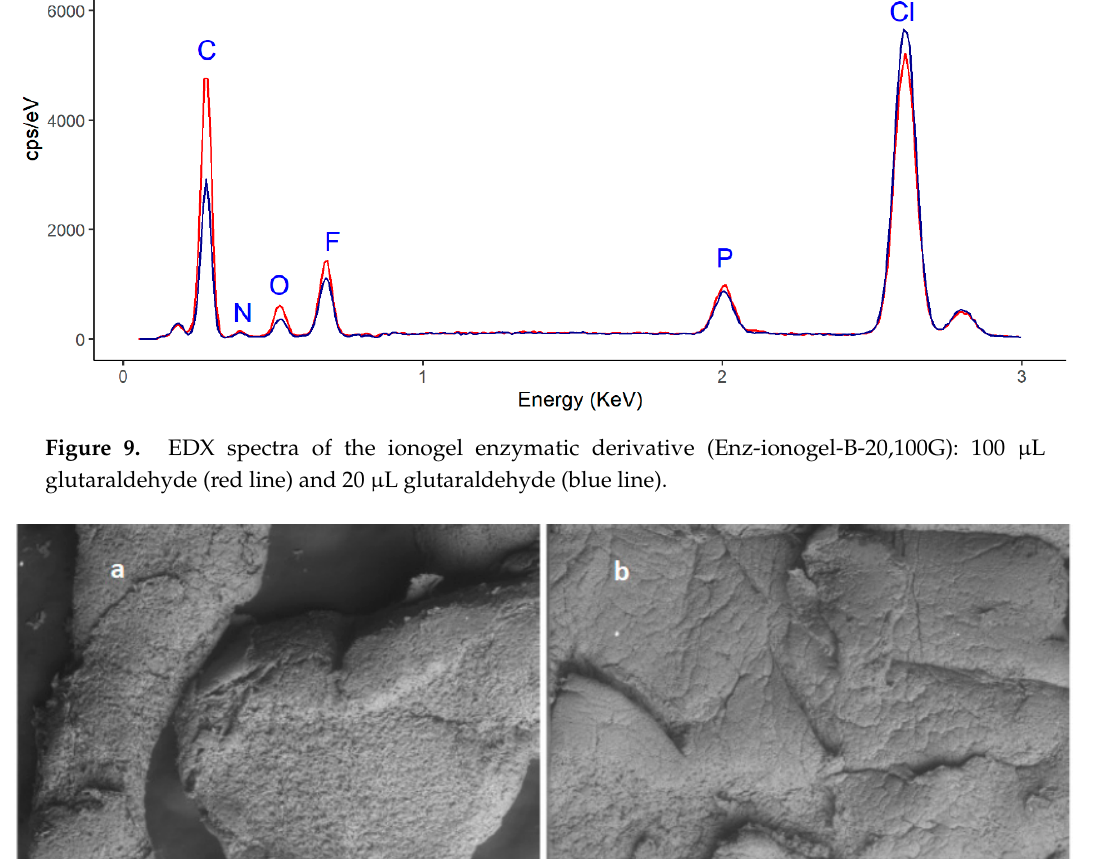
Figure 10. Scanning electron micrographs of the ionogel with diluted enzyme incorporating